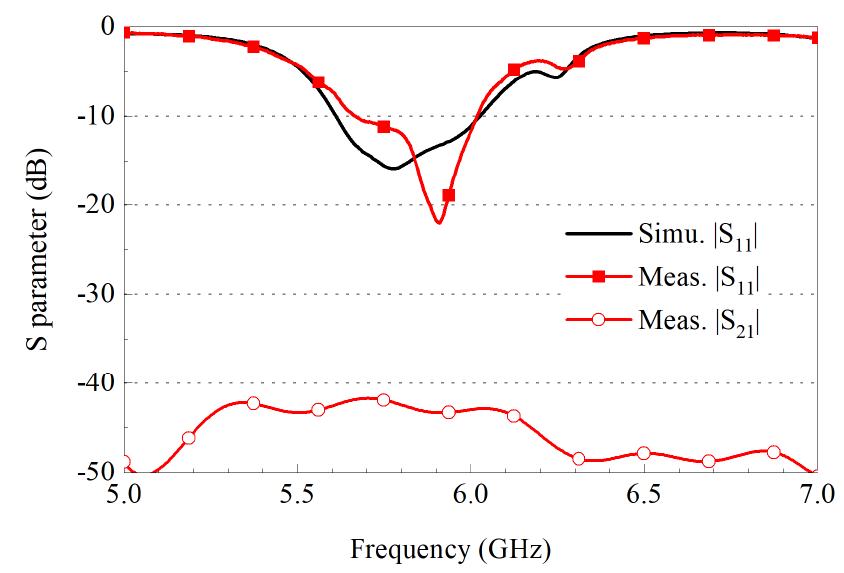
Figure 12. Simulated and measured S parameters in the lower frequency band.